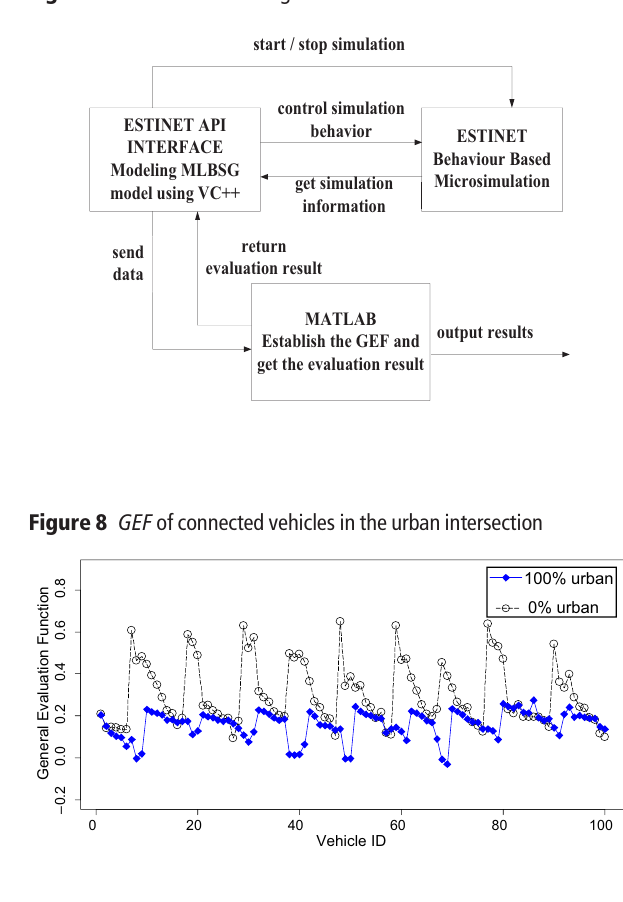
Figure 6 Road network topology of simulated case